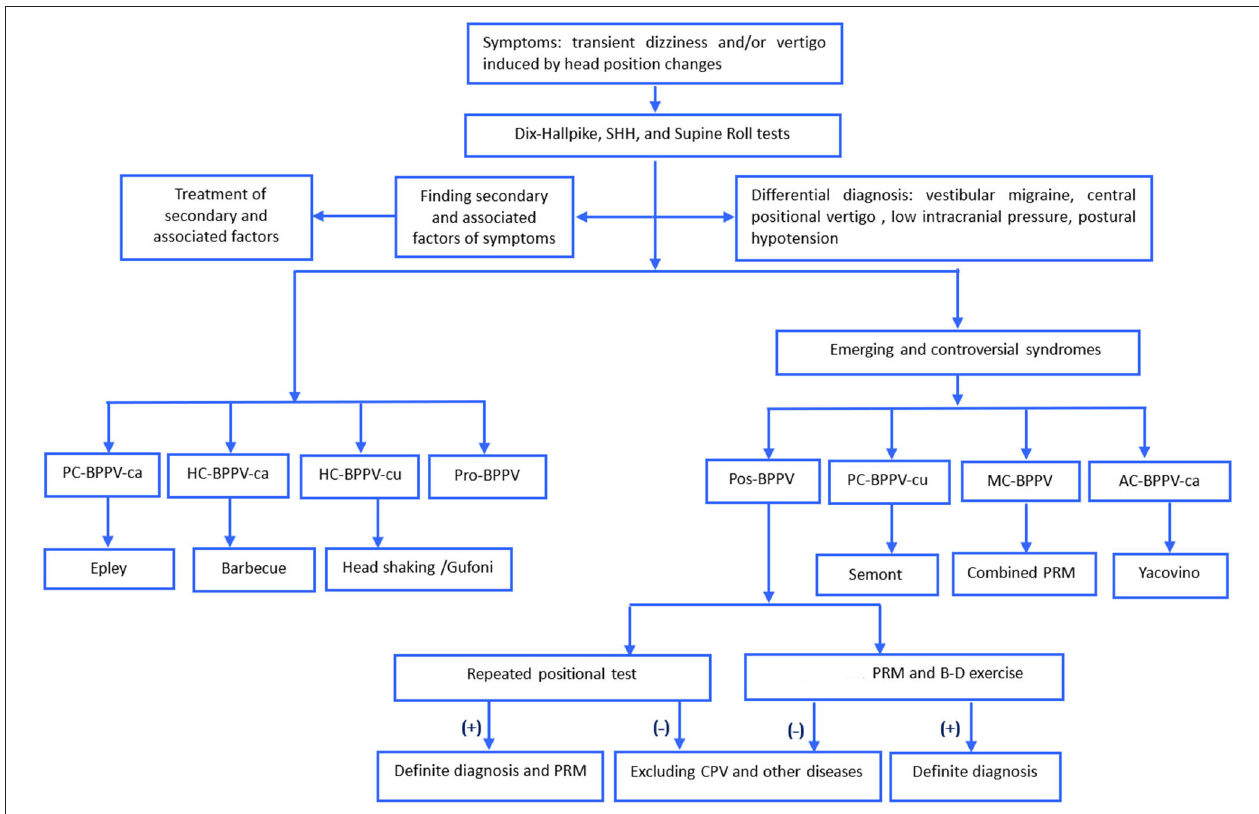
FIGURE 1 | The process for diagnosis and treatment of BPPV. AC, anterior canal, ca, canalolithiasis; cu, cupulolithiasis; B-D, Brandt-Daroff; BPPV, benign paroxysmal positional vertigo, HC, horizontal canal, MC, multiple canal, PC, posterior canal, Pos, possible, PRM, particle repositioning maneuvers; Pro, probably spontaneously resolved, SHH, straight head